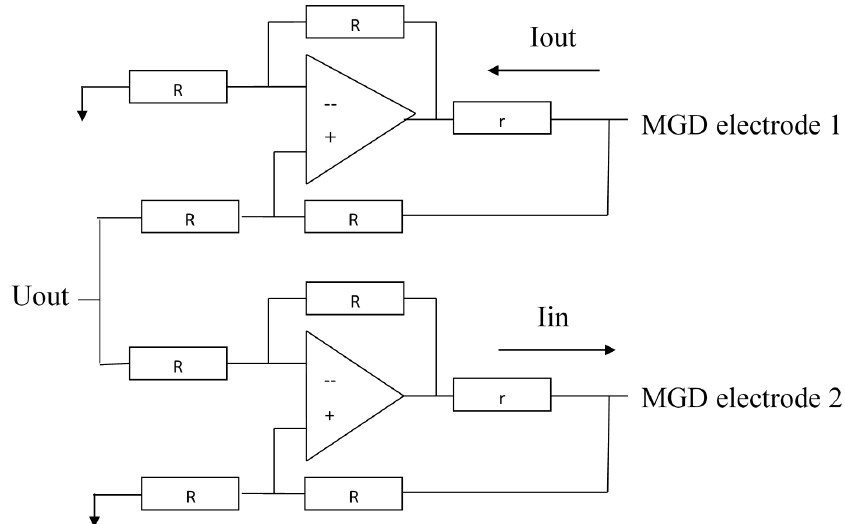
Figure 5. Electronic circuit for the current formation in the MHD cell.